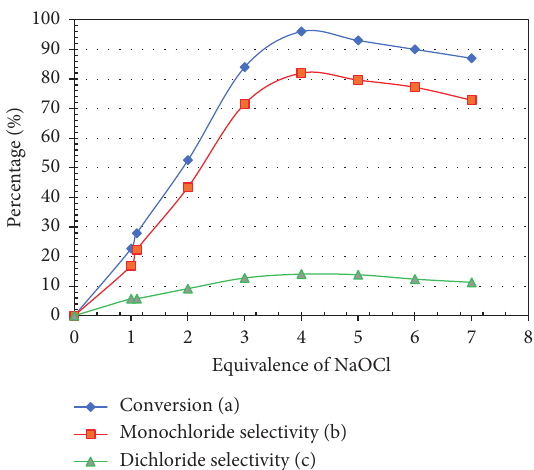
Figure 1: Effect of FeCl